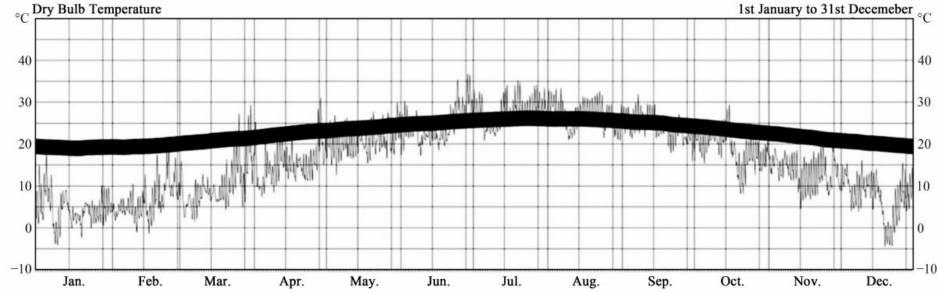
Figure 2. Daily dry bulb temperature profile in Hangzhou city.